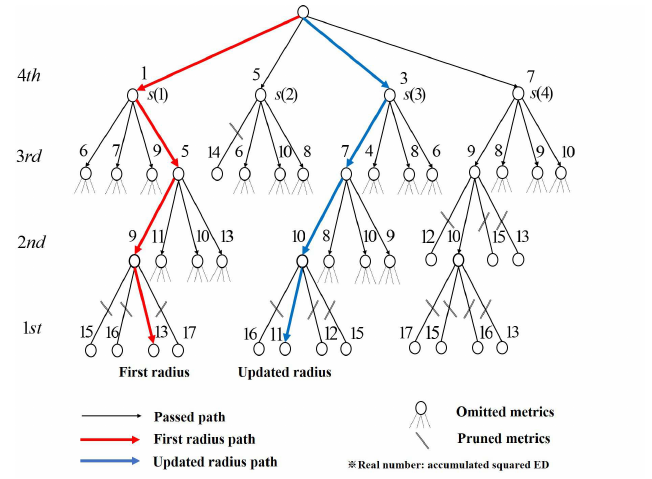
Figure 2. Depth-first sphere decoding (DFSD) tree structure in 4 × 4 MIMO-OFDM system with quadrature phase shift keying (QPSK)